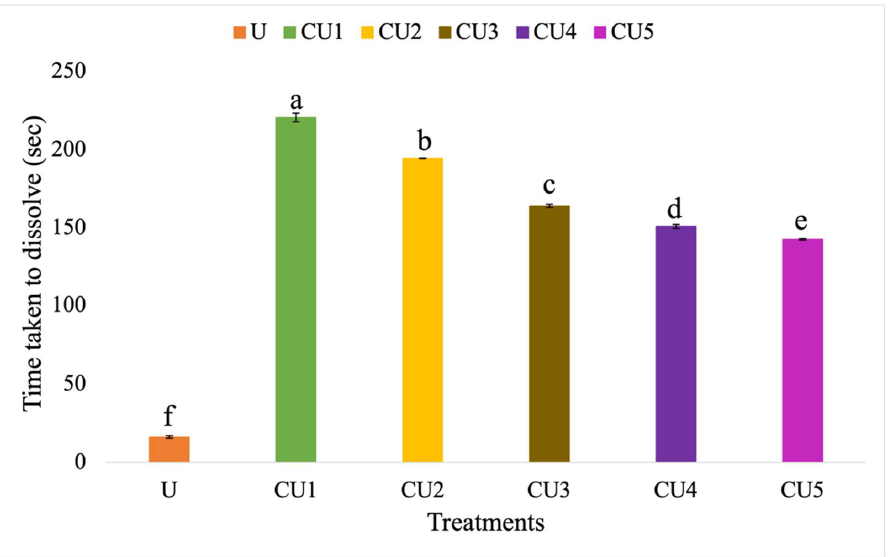
Figure 5. Dissolution rates of uncoated and coated urea. Mean values with different letter(s) indicate significant differences between the treatments using Duncan’s test at p ≤ 0.05. The error bars show the standard errors on the replicates in the means of each treatment.